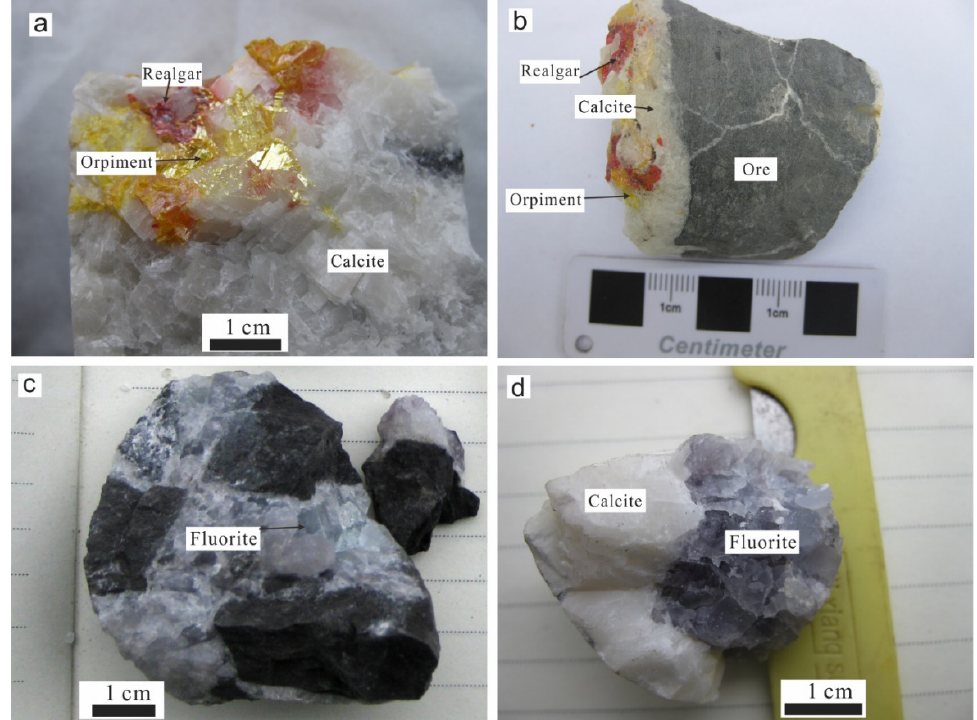
Figure 4. Photographs of calcite and fluorite samples from Shuiyindong. ( a,b ) Calcite samples containing intergrown realgar and orpiment from drill cores at the periphery of decarbonated rocks; ( c,d ) fluorite samples cementing argillite breccia or intergrowth with calcite at the vicinity of SBT.